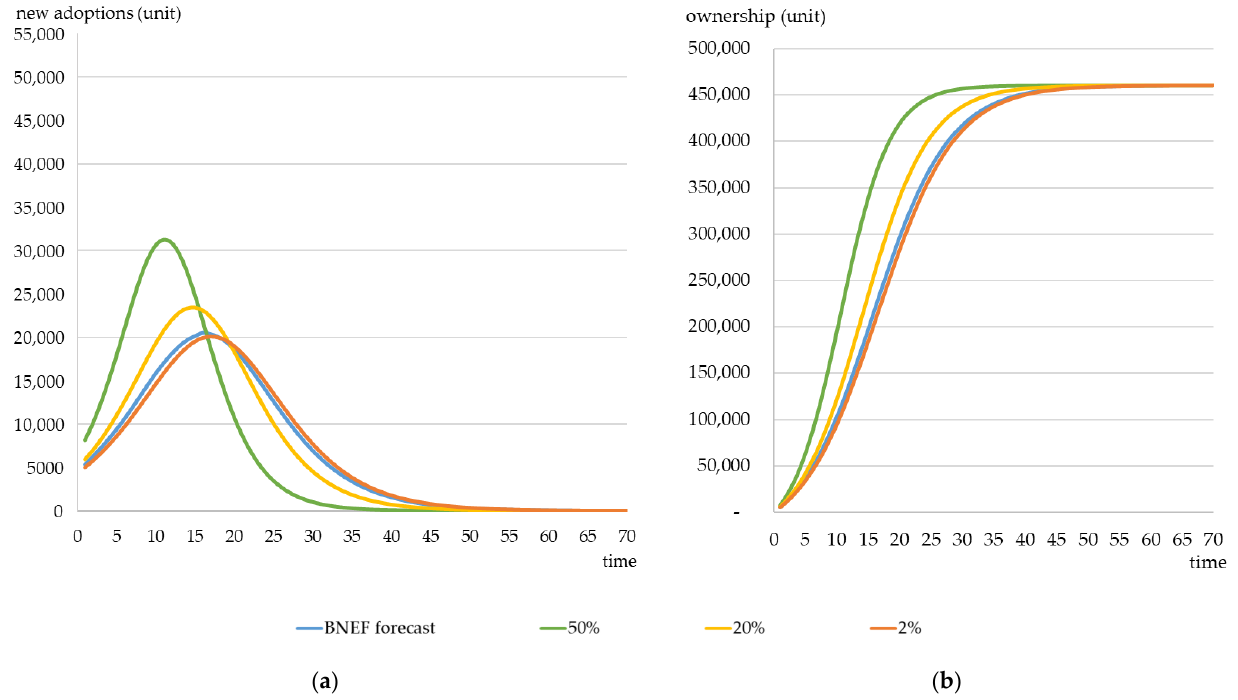
Figure 5. ( a ) In the scenario with a 50% replacement rate, the numbers of new adoptions, which are simulated in accordance with the BNEF estimation, involve annual drops of 50%, 20% and 2%; ( b ) In the scenario with a 50% replacement rate, the numbers of new adoptions, which are simulated in accordance with the BNEF estimation, involve annual drops of 50%, 20% and 2%.